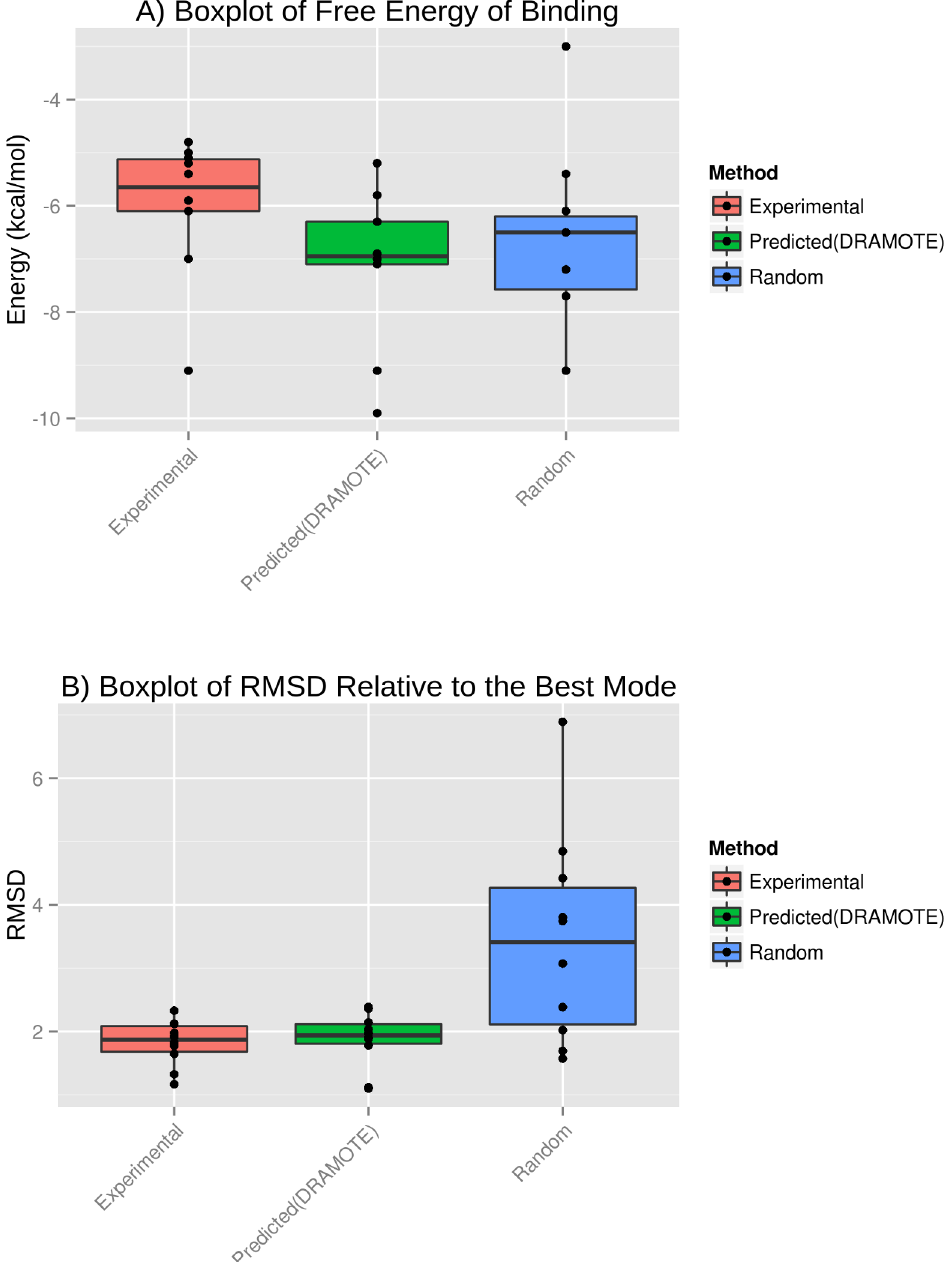
Fig 2. Boxplot over free energy of binding and RMSD values for experimental, random and DRAMOTE docking results. The random set is based on choosing 10 random drugs from approved drugs list in DrugBank database. The experimental set includes the top 10 drugs as listed in the original BioAssay AID 938 of PubChem database.